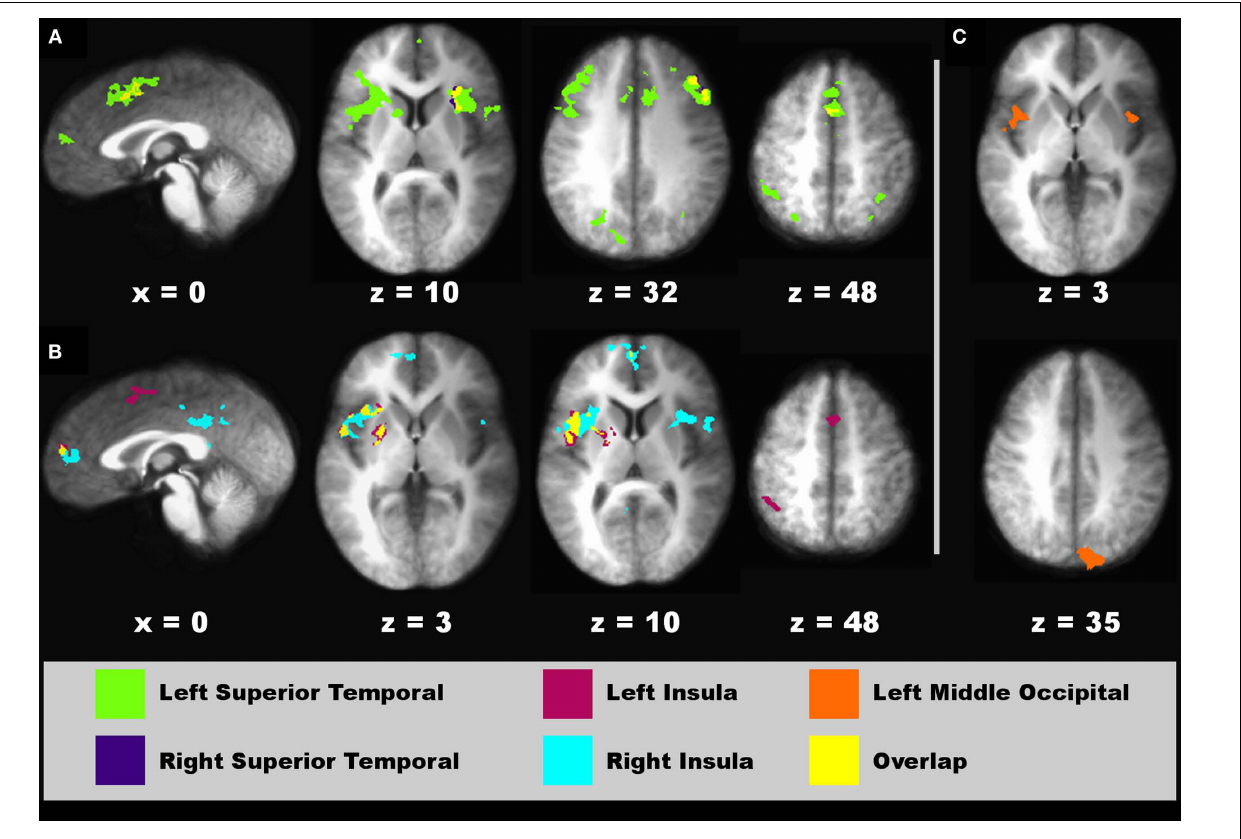
posterior insula seeds. (C) Left middle-occipital seed (orange).The spatial overlap between two seeds in their interacting regions (A,B) is shown in yellow. Coordinates beneath sagittal and axial sections represent the distance in millimeter from the anterior commissure: x , right ( + )/left ( − ); superior ( + )/inferior ( − ). See Table 3 for details about individual activation